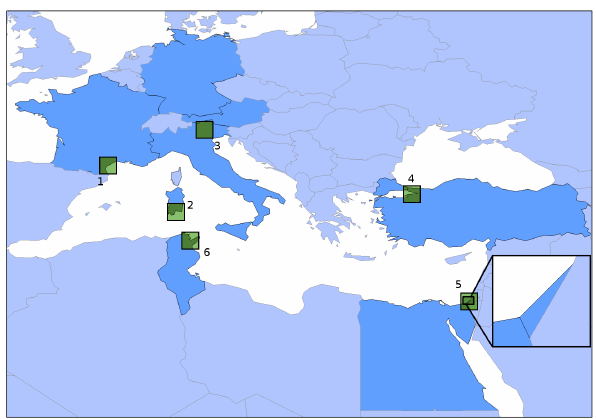
Fig. 1. Locations of representative Mediterranean catchments considered in this study (see also Table 1): 1 – Thau (France), 2 – Riu Mannu (Italy), 3 – Noce (Italy), 4 – Kocaeli (Turkey), 5 – Gaza (Palestine), 6 – Chiba (Tunisia). Model verification areas that correspond to the 4 (cid:2) 4 stencil of ENSEMBLES grid-points centered in each catchment appear as shaded; see main text for details.